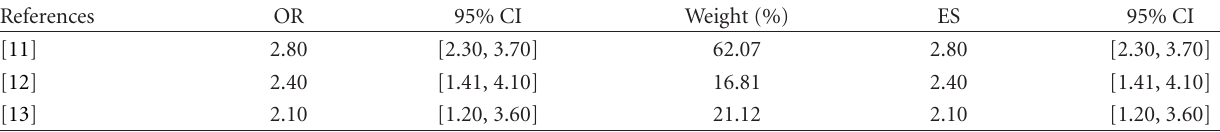
Table 1: Summary of the studies of the association between AD and hip fracture (OR and 95% CI fixed).